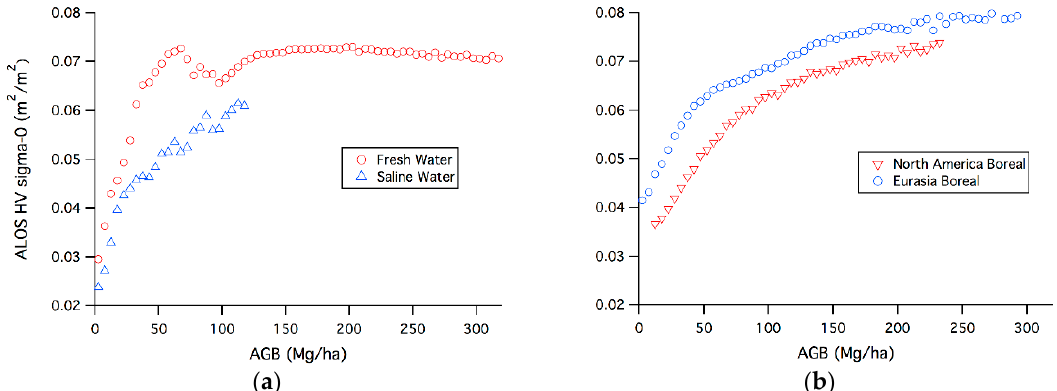
Figure 2. Correlation between bin-averaged ALOS HV backscatter sigma-0 (m 2 ·m − 2 ) and middle of bin AGB value (Mg·ha − 1 ) for ( a ) flooded forests; and ( b ) boreal forests. Outlier bins (such as some low bin values below 10 Mg·ha − 1 , and higher bins when the number of shots within the bin drop below 500, or 100 for the case of saline water flooded forests) are dropped. The flooded forests in ( a ) are divided into fresh-water and saline water (mangroves); boreal forests in ( b ) are divided by continent into North American boreal and Eurasian boreal.